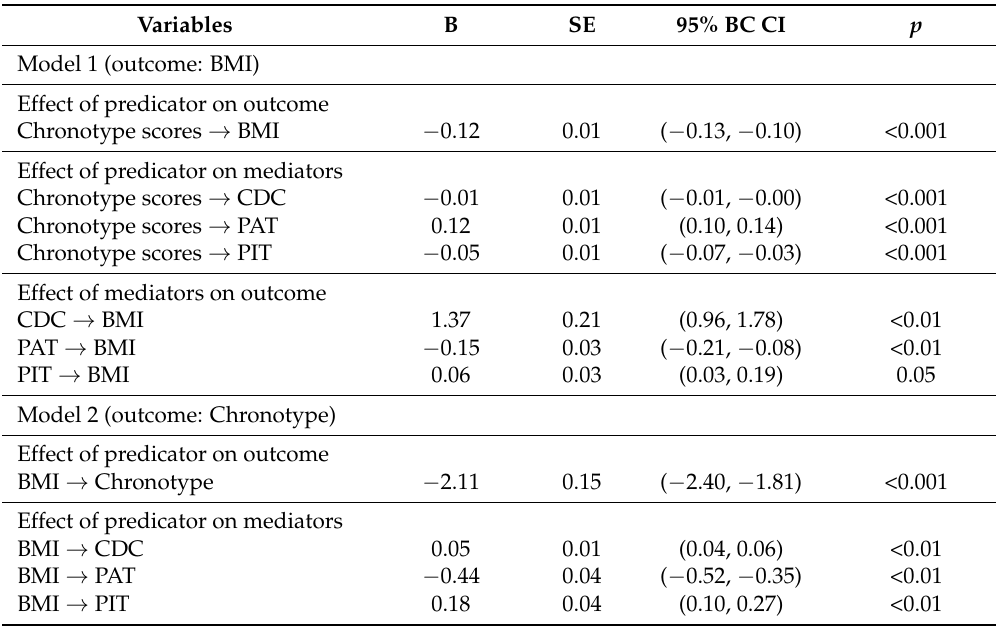
Table 3. Bootstrapping analyses were used in primary and reversed model,